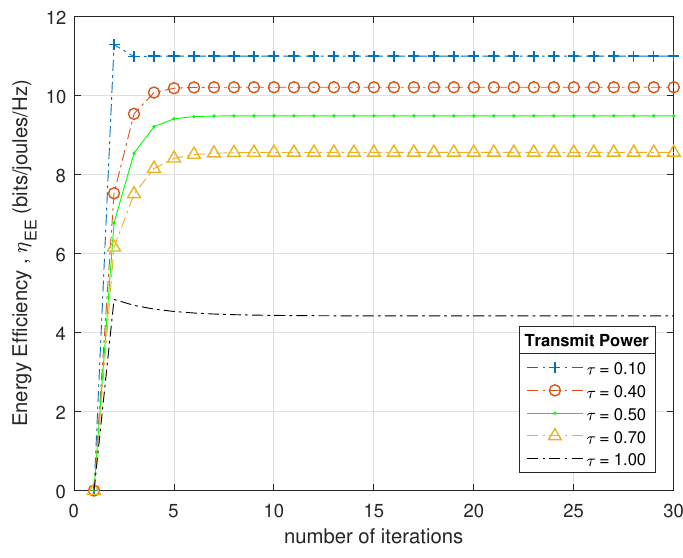
Figure 10. EE with respect to switching ratio.